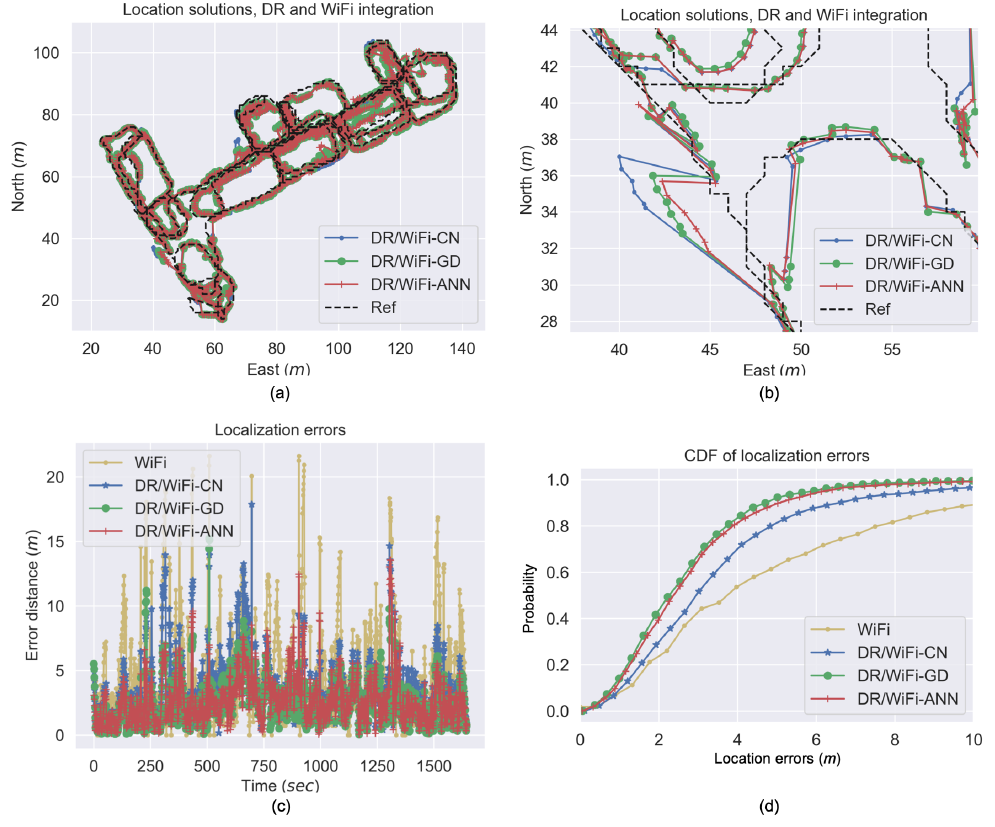
Figure 12. DR/WiFi integrated solutions ( a ), zoomed-in plots ( b ), location errors ( c ) and their CDF ( d ). Table 2. Statistics of location errors (unit: